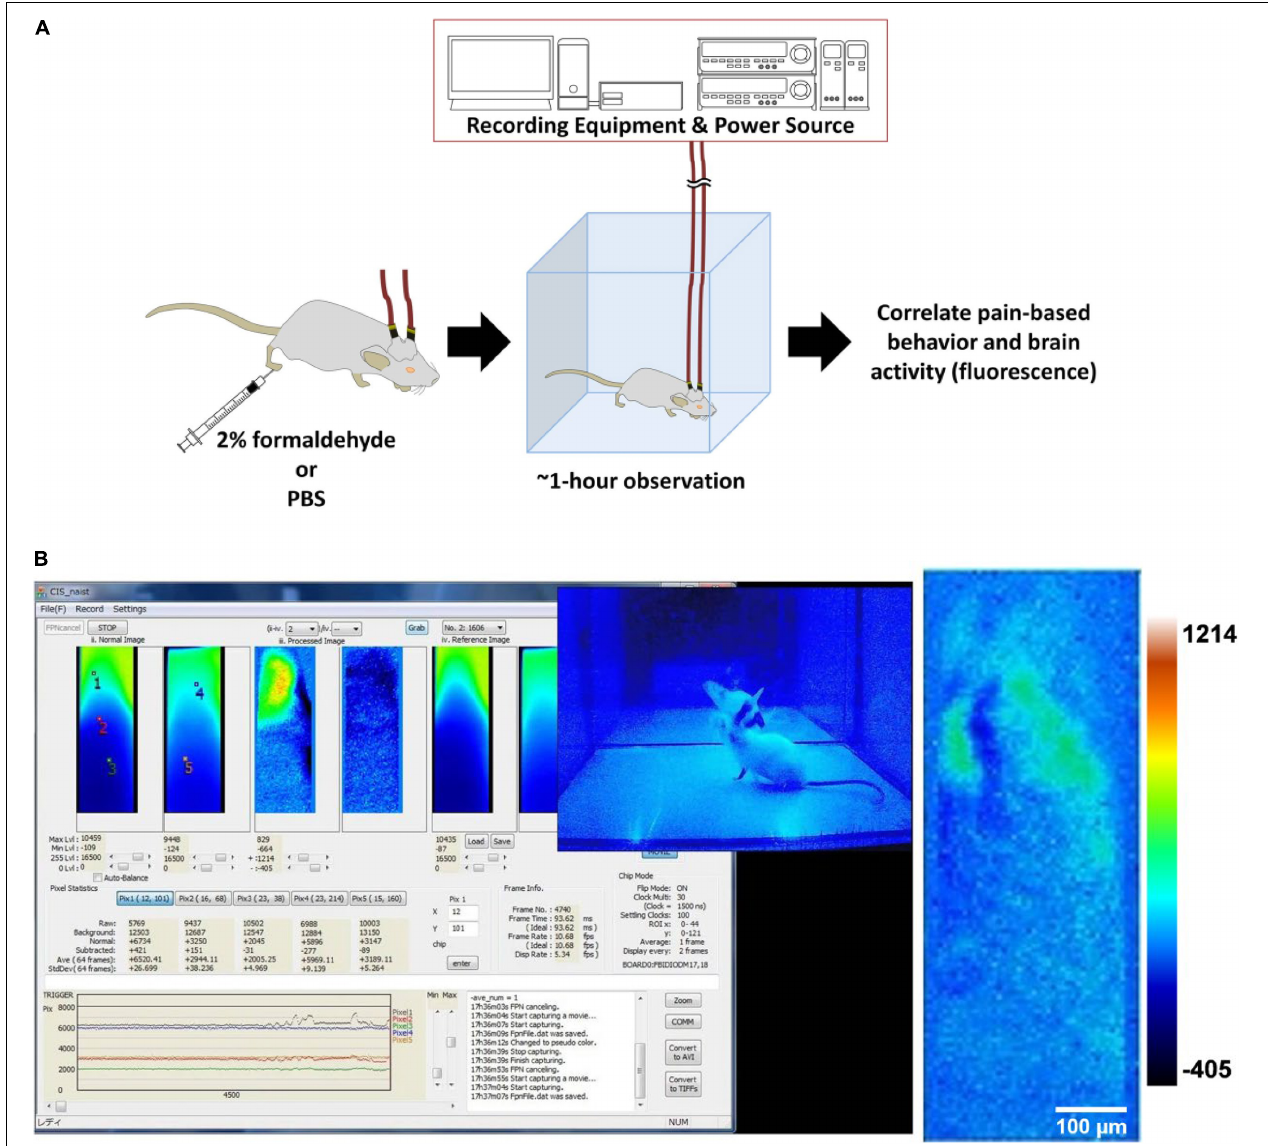
FIGURE 3 | Formalin test with brain activity imaging. (A) The experimental design of the modified formalin test. (B) Left: Screenshot of the computer monitor during a formalin test. On the screen is the CIS_NAIST software that displays the windows (40 × 120 pixels, 300 × 9,000 µ m) for raw, processed, and reference frames of real-time video data, in pairs from left to right. The left of the pair is the fluorescence image from the CeLC, and the right of the pair is from the DRN. Also displayed are the fluorescence level traces at the bottom and frame number information at the middle right. The overlying the CIS_NAIST software window is the video feed of the mouse behavior from the webcam; Right: A sample of a processed image of the CeLC with discernible fluorescent structures. Heatmap values are voltage values that represent (cid:49) F.